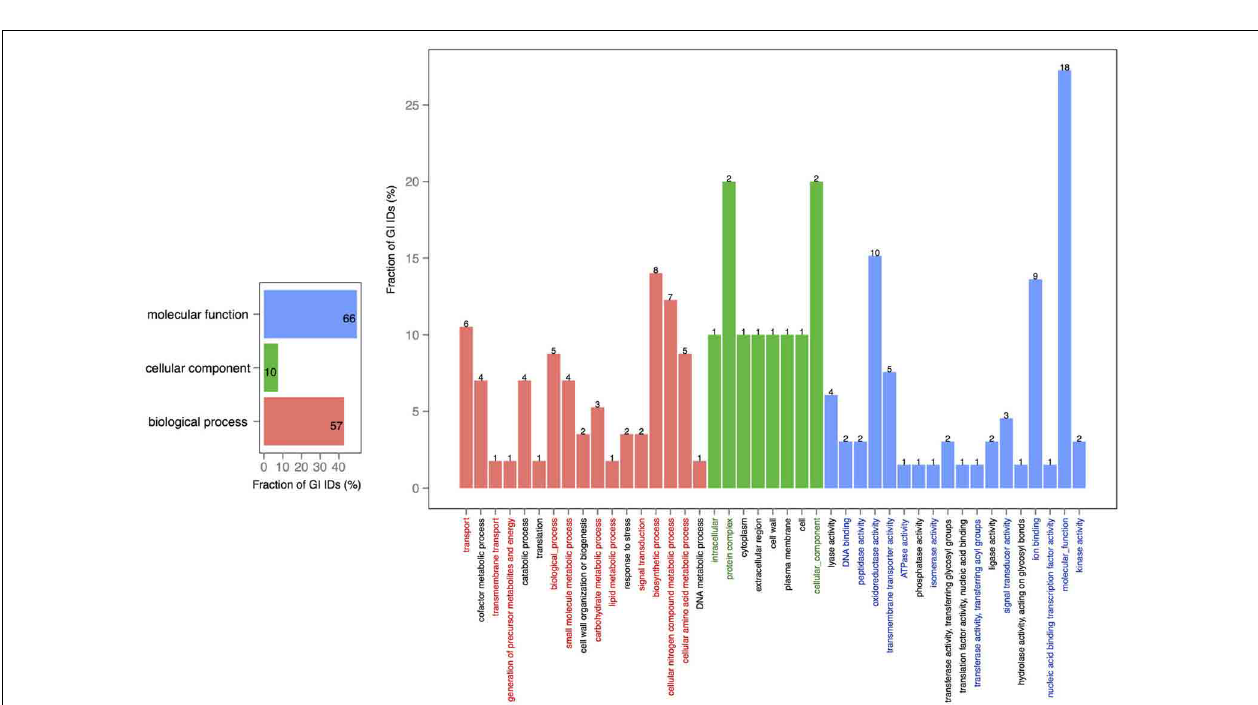
GO IDs that were connected to the pathway. The color code is as follows: red is the biological process, green is the cellular component, and blue is the molecular function.